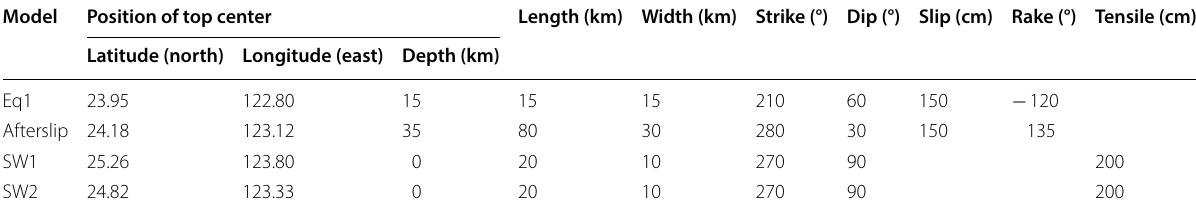
Table 1 Model parameters of the faults and dikes used in this study Model Position of top center Latitude (north) Longitude (east) Depth